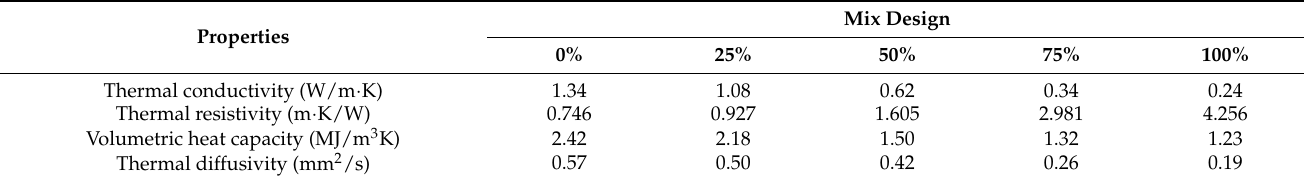
Table 12. Thermal property of mortars with vermiculite [17].